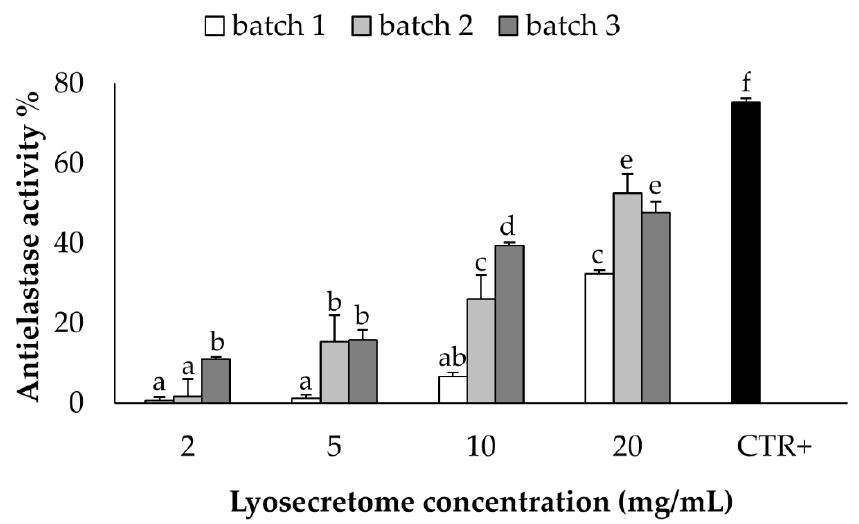
Figure 6. Anti-elastase activity was tested for the three batches at different Lyosecretome concen- trations: 2, 5, 10, and 20 mg/mL, obtaining a dose-dependent trend. Mean values ± LSD ( n = 3), ANOVA. Different letters (a, b, c, d, e, and f) indicate significant differences between the means ( p < 0.05), whereas the same letter indicates no significant difference ( p > 0.05).